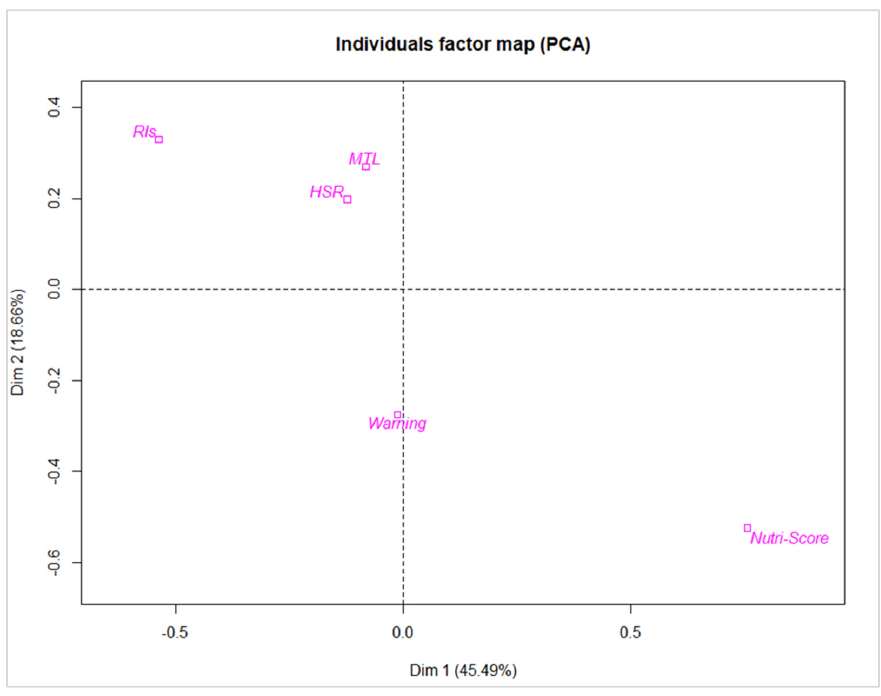
Figure 3. Principal Component Analysis map.